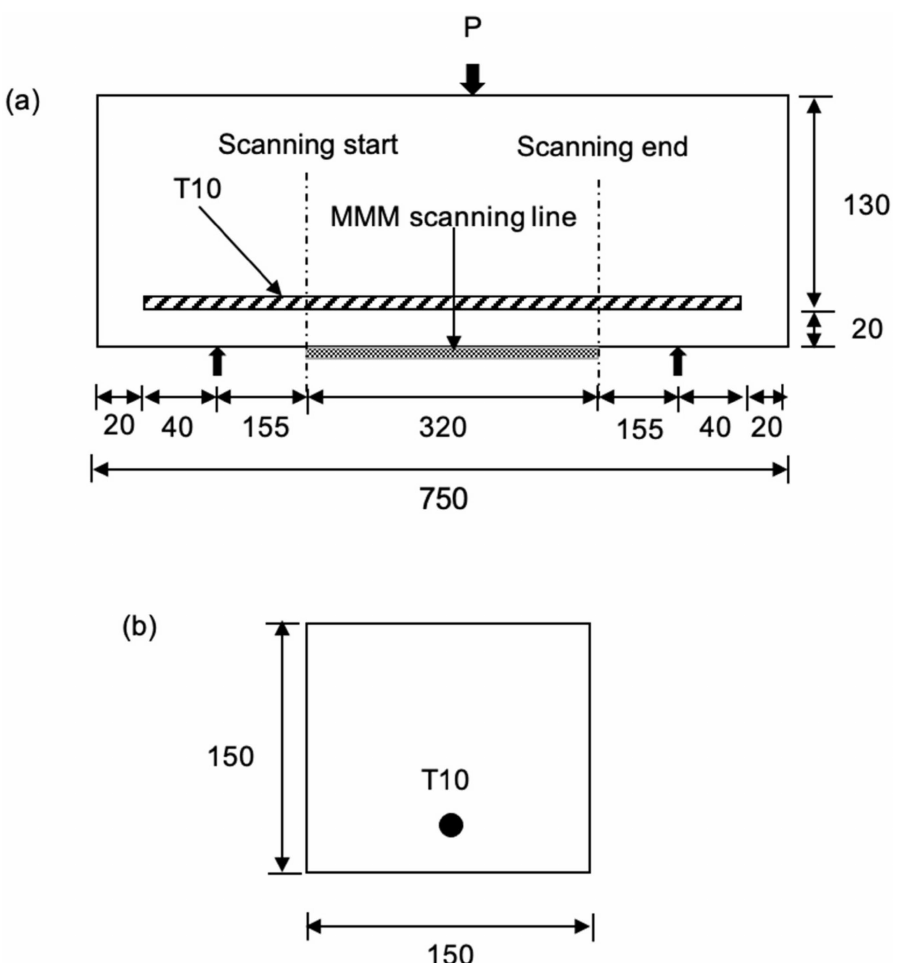
Figure 2. Schematic diagram of the RC prism details ( a ) side view ( b ) cross-sectional view (unit in